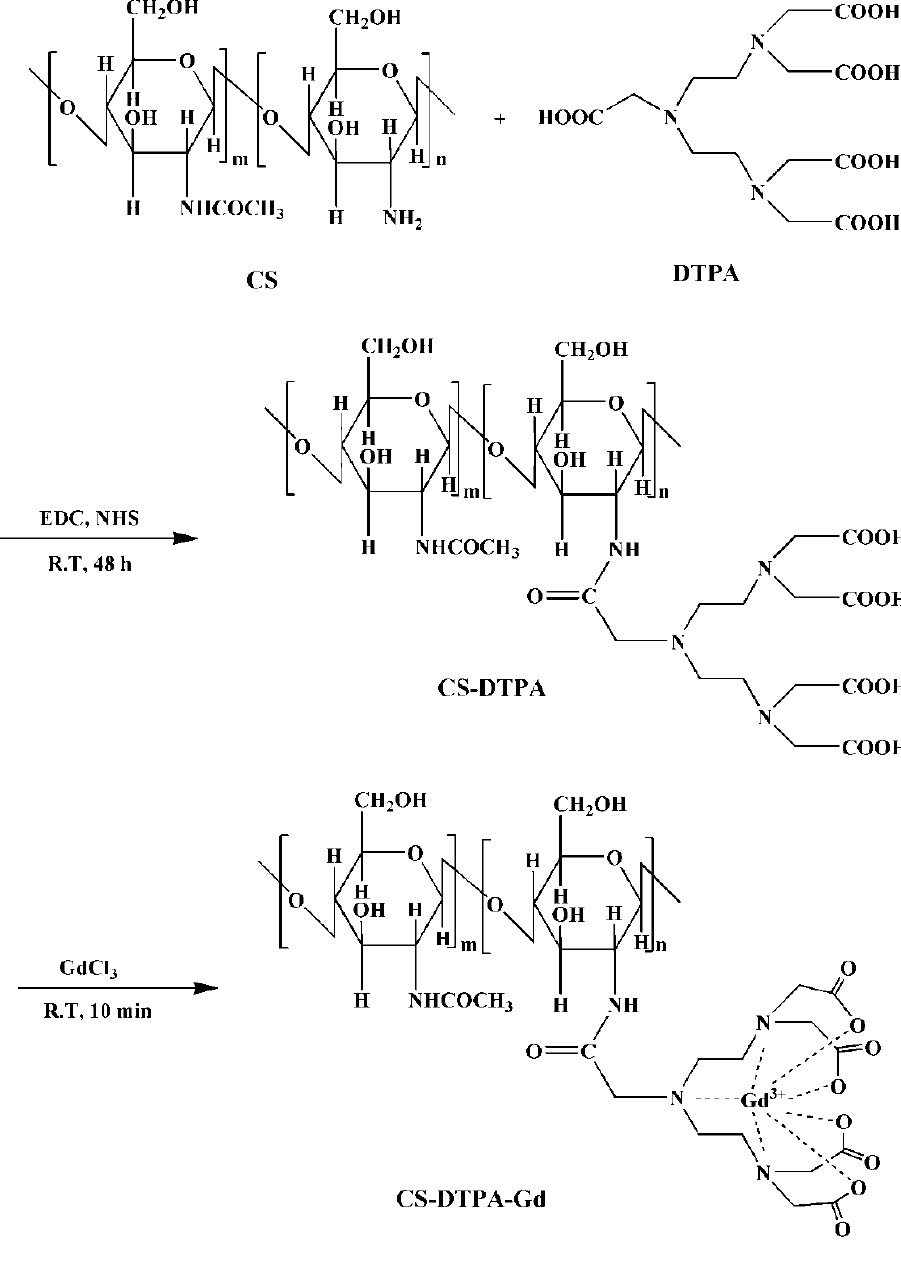
Figure 1. Synthesis scheme of